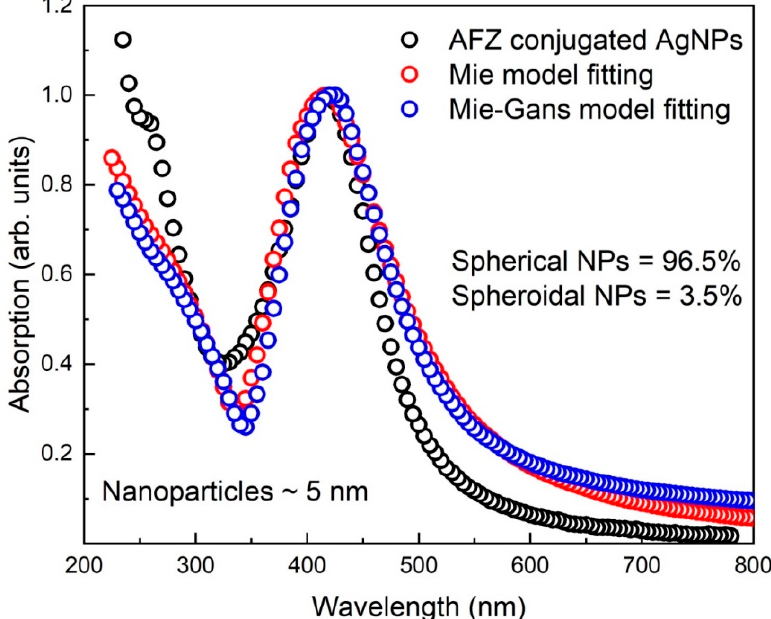
Figure 5. Absorption spectrum of the SPR max normalized afzelechin conjugated AgNPs and its fitting with the Mie and Mie Gans models. Fitting models indicate an increase in the nanoparticle size and deviation from the spherical geometry by 3.5% due to conjugation.